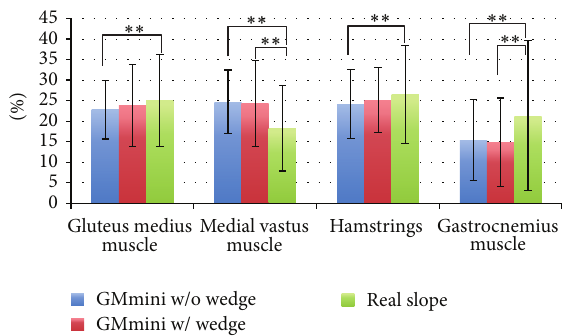
Figure 18: Average muscle activities while descending a slope. Table 2: Effect size of each muscle in slope descending. Muscle 𝐹 (2,1071) 𝑃 Effect